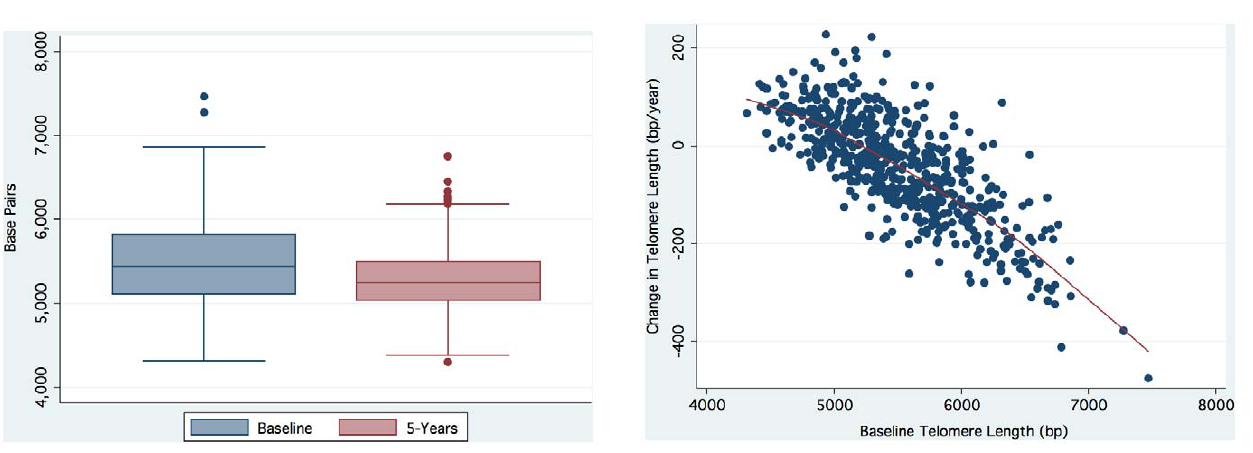
Figure 3. Scatterplot of change in telomere length against baseline telomere length (r=0.76; p , 0.0001).